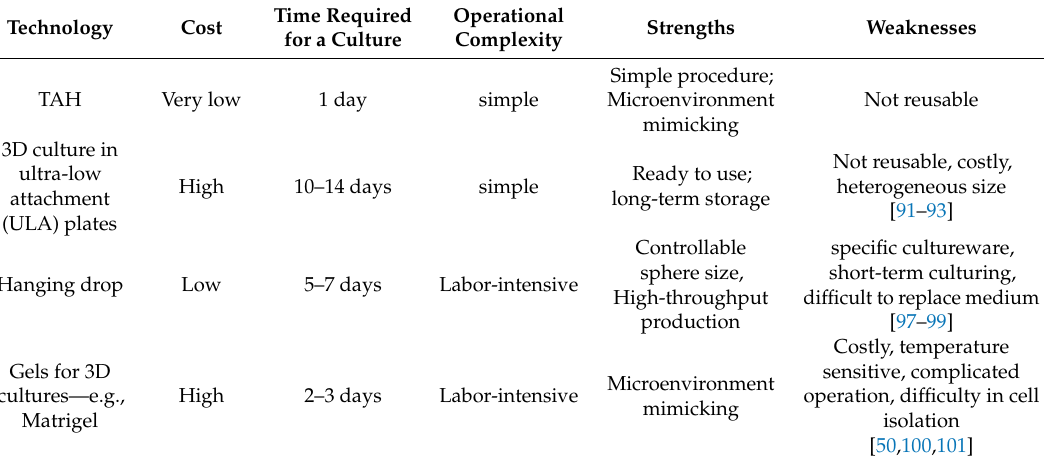
Table 2. Comparison of Enrichment Technology for Cancer Stem